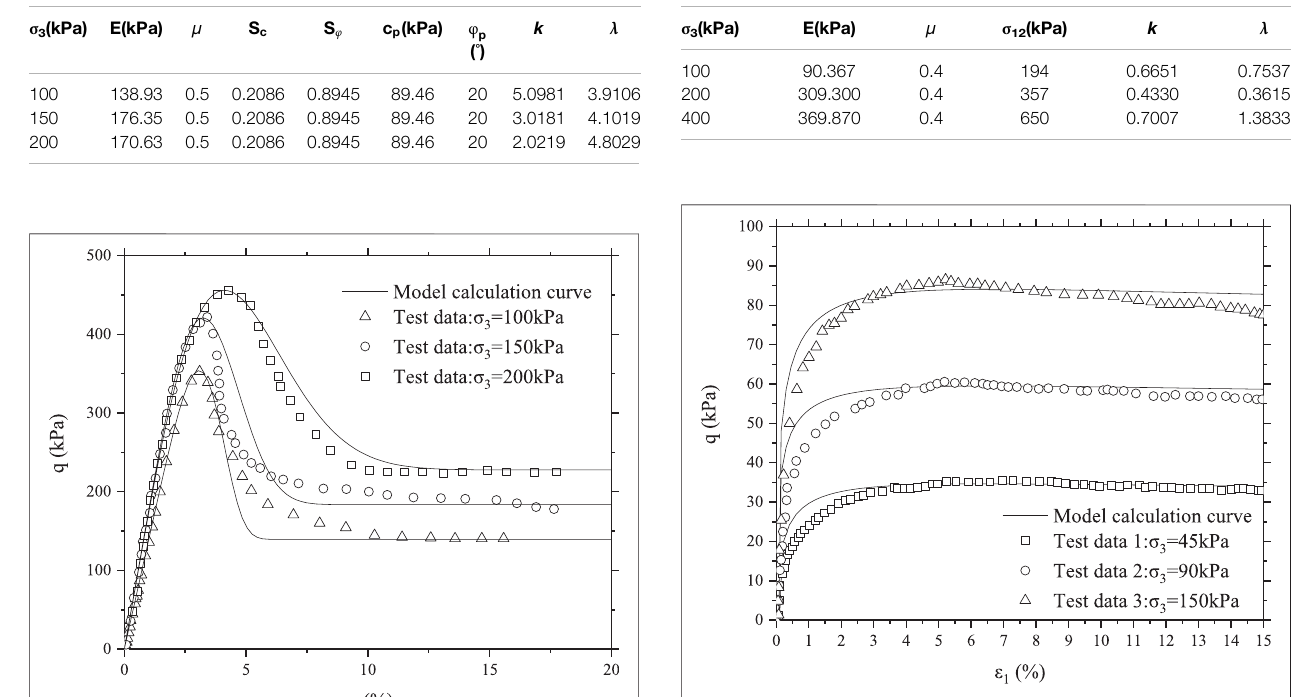
TABLE 4 | Model parameters in reference Zhu and Xiao-qiang, 2018.